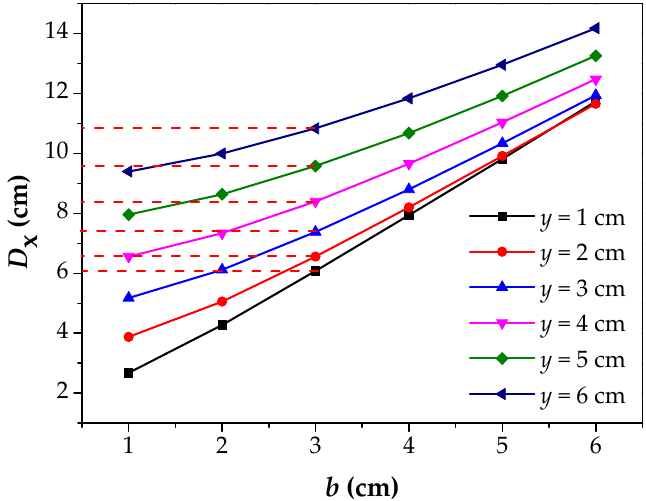
Figure 7. The relationship between D x and b under different y . D x : The intersecting point distance between curves of magnetic flux component of x direction at different lift off heights; b : the half of corrosion width; Y : the lift off height.